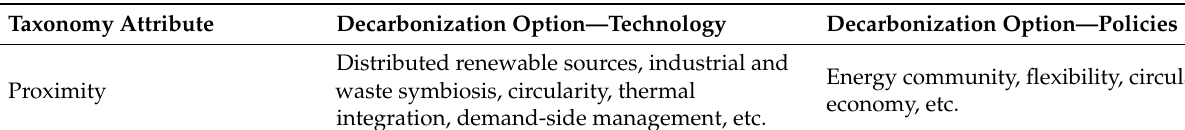
Table 12. Possible decarbonization options and policies linked to the selected taxonomy attributes of the industrial